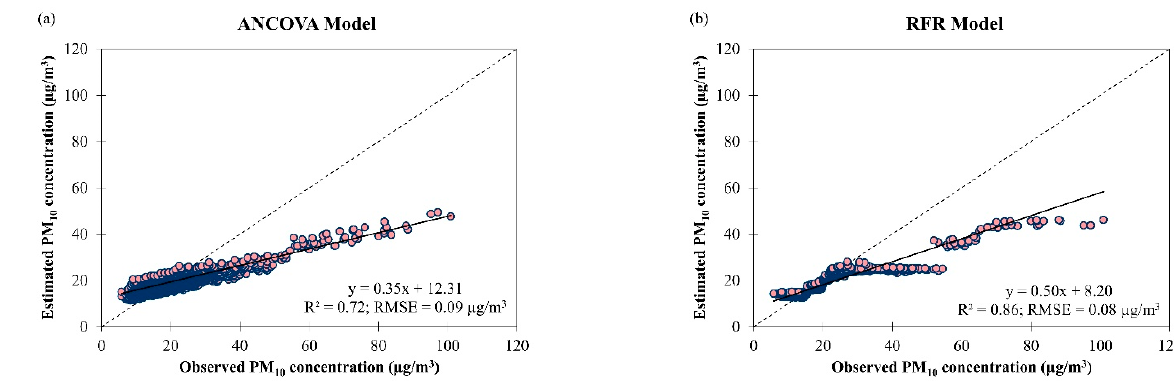
Figure 16. Scatter plots of estimated daily PM 10 concentration against observed daily PM 10 concentration by ( a ) ANCOVA and ( b ) RFR models for overall air quality in Brunei Darussalam from January 2009 to December 2019.